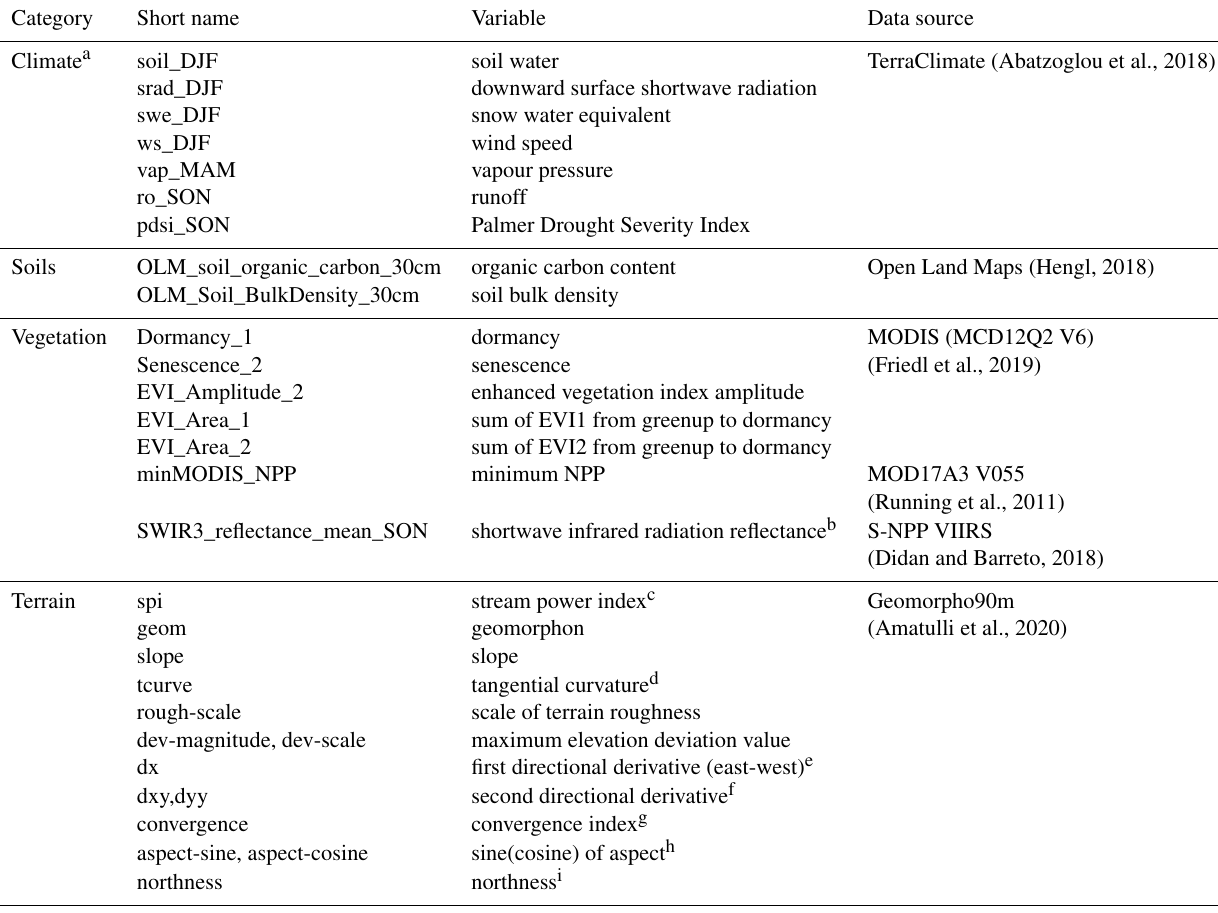
Table A1. The 30 predictors selected using VIF with a threshold value of 5. The final 16 features that were further selected by the RFECV algorithm for use in the final model are listed in Table 1. See Sect. 2.2.1 for further discussion on the variable